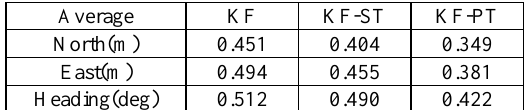
Figure 5. True Position and Heading RMS error Tables 1 and 2 show the average and maximum absolute errors respectively. The absolute errors in the estimates computed by KF-PT were on the average smaller compared to both KF and KF-ST.